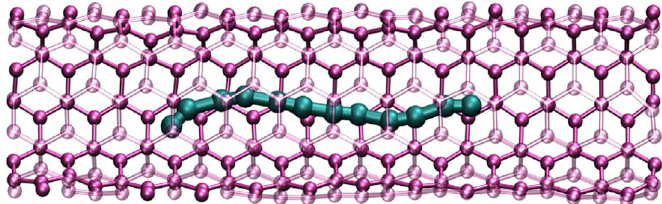
Figure 2. Structure model of 12 atom-long carbon chains inside a (6,6) carbon nanotube. Reproduced with permission from [11].